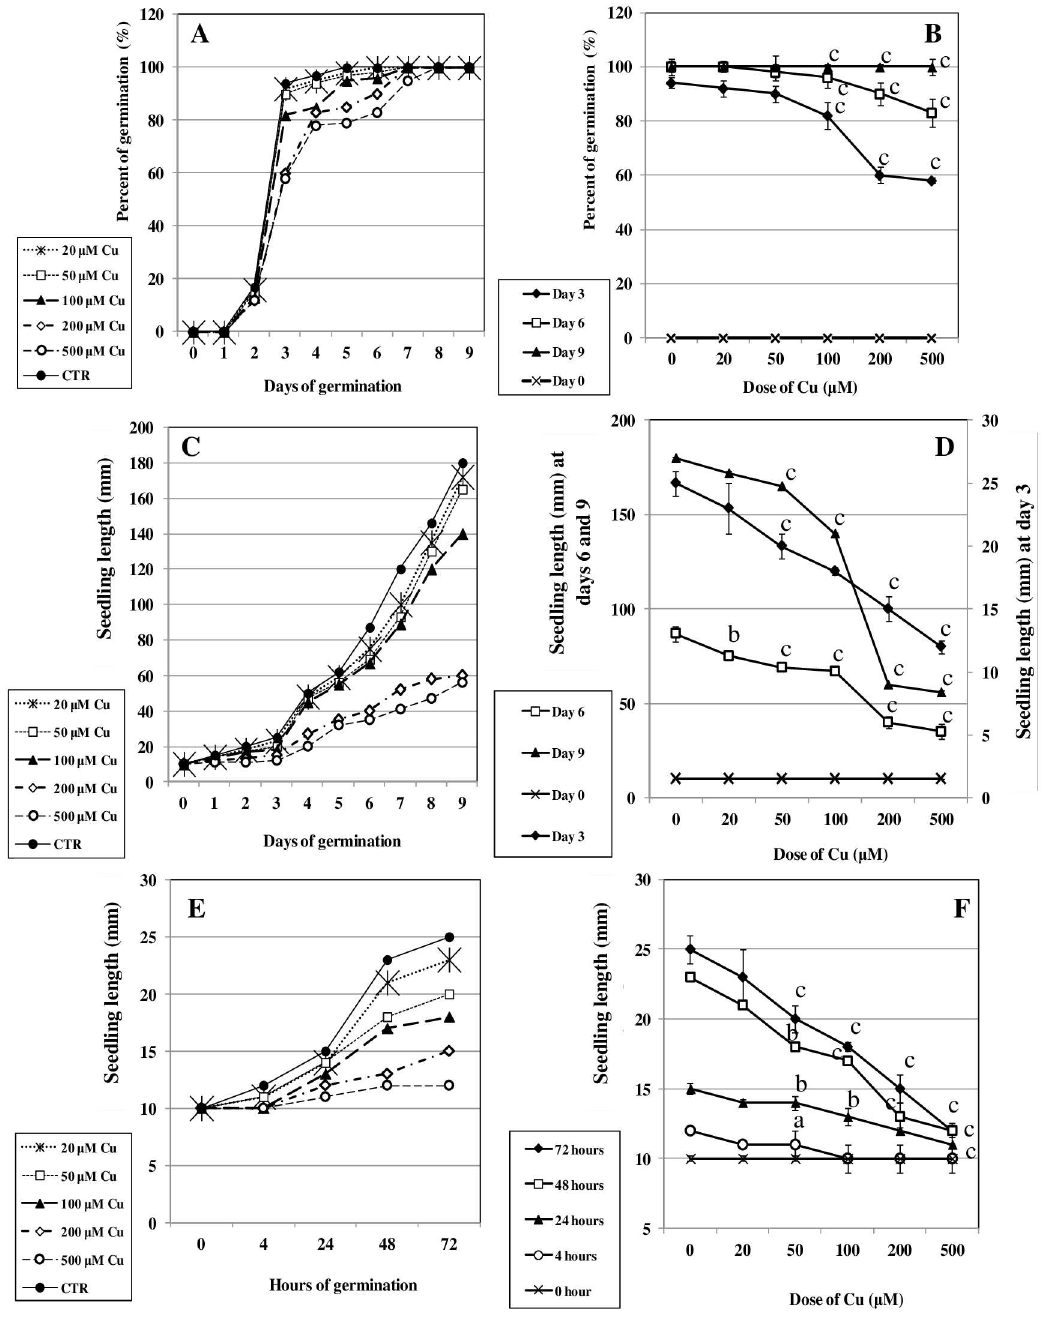
Fig 2. Time courses of (A, B) germination rate and (C, D, E, F) seedling length in bean seeds in the absence (CTR) and in the presenceof CuCl 2 (concentrations 20, 50, 100, 200, 500 μ M). Letters indicatesignificantdifferences comparedwith the respectivecontrol sample (a: p < 0.05, b: p < 0.01 and c: p <